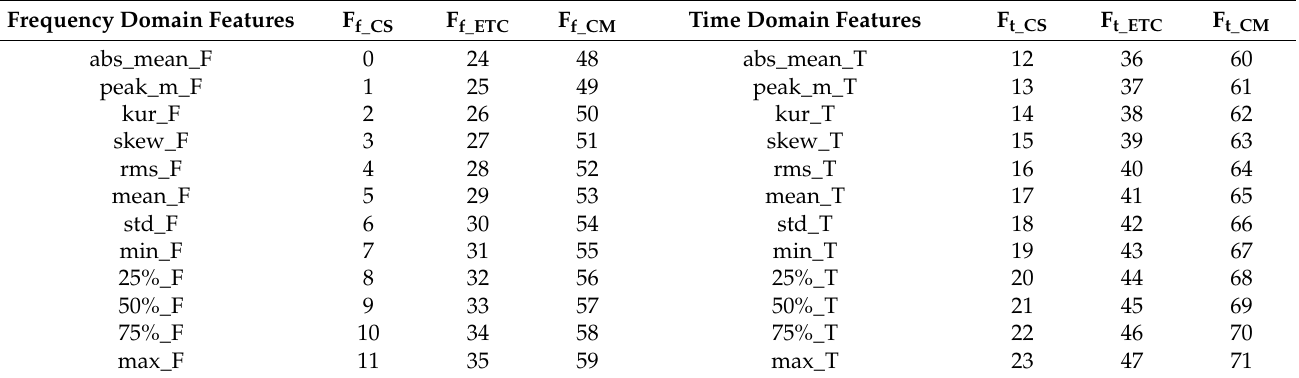
Table 1. Feature